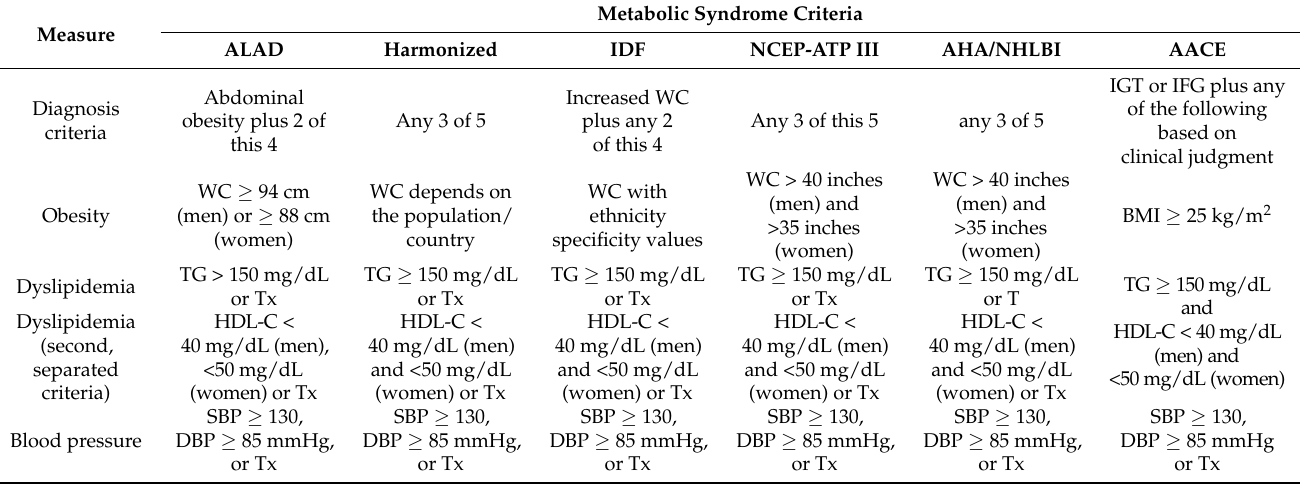
Table 1. Definitions of metabolic